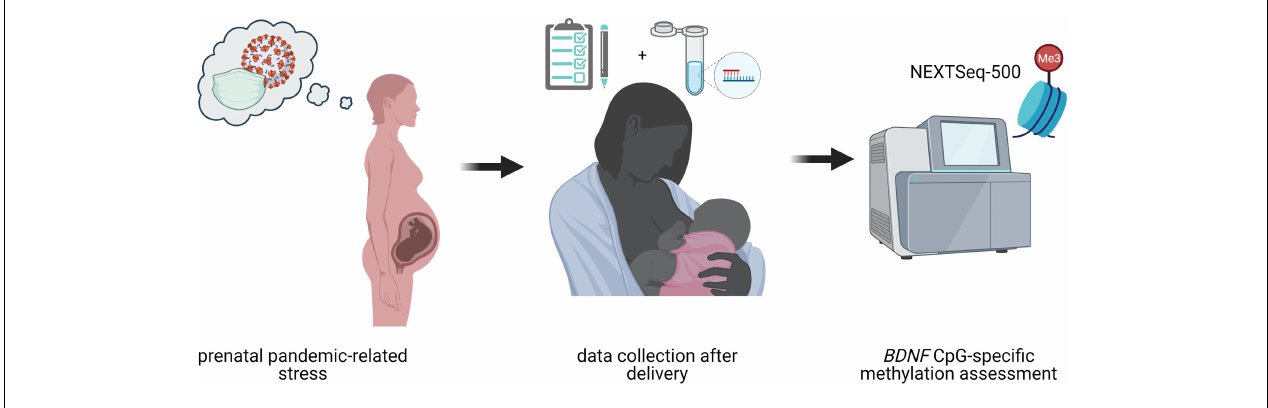
FIGURE 1 | Methodology of the study.